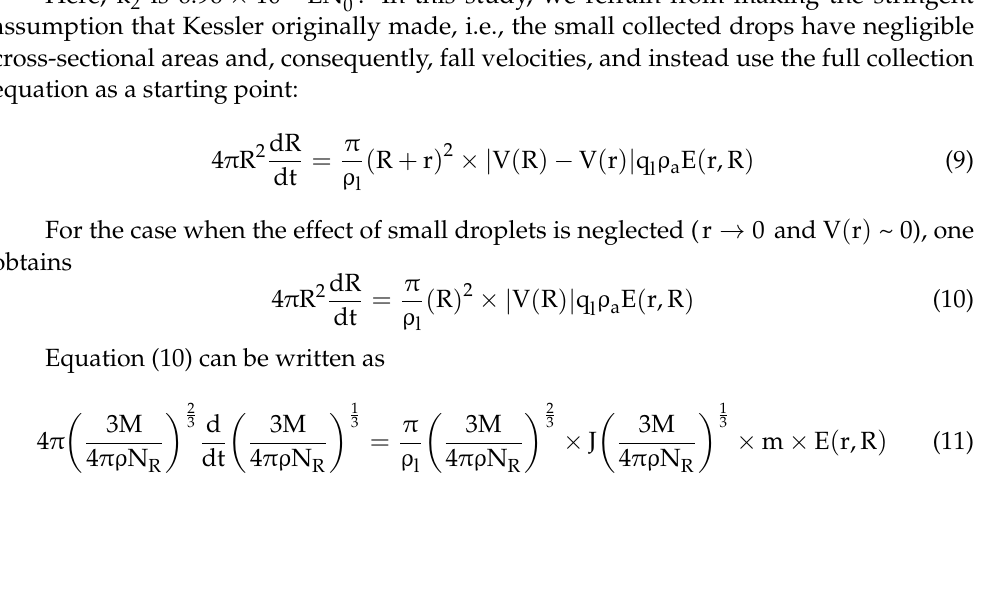
) obtained from the 1 (cid:0) (cid:1) − 1 = 3.5 × 10 − 4 gm − 3 s − 1 . 1 (cid:2912) ~ 0.1.